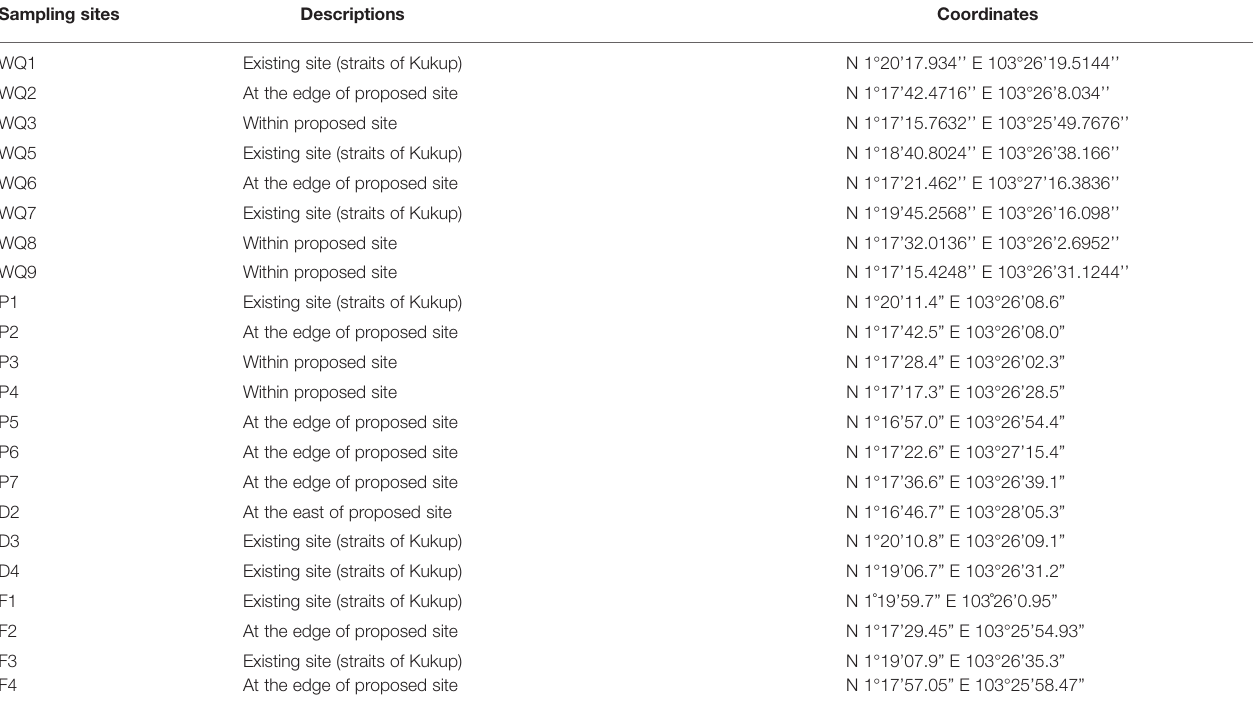
TABLE 1 | Coordinates of 16 sampling sites for water quality and marine sediments assessment in degrees-minutes-seconds (DMS). Sampling